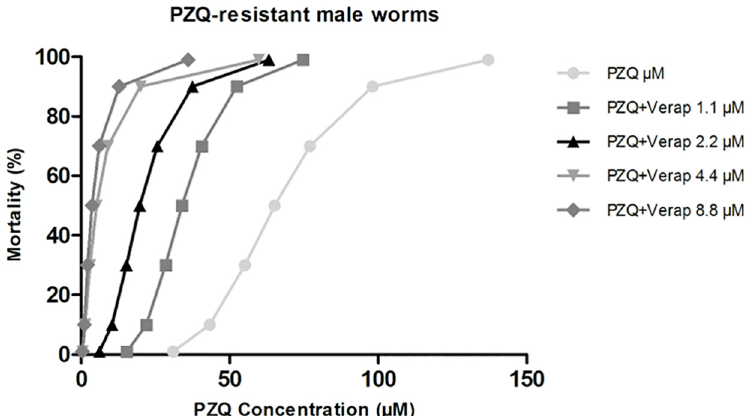
Fig 10. Mortality trends of S . mansoni adult males PZQ-resistant exposed to PZQ in the presence of Verapamil. The mortality levels to increase concentrations of Verapamil (1.1 – 8.8 μ M) are represented by survival curves. Additionally, the survival curve of parasites unexposed to Verapamil is also represented. The Probit regression model was used with a 95% of confidence.